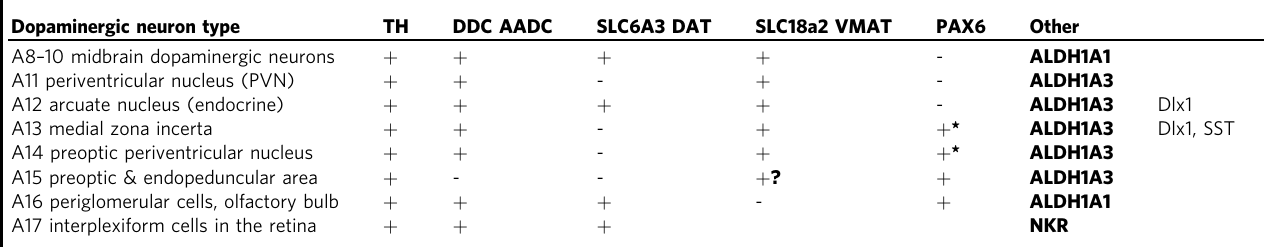
Table 1 DA neuron heterogeneity: mDA and non-mDA markers. Dopaminergic neuron